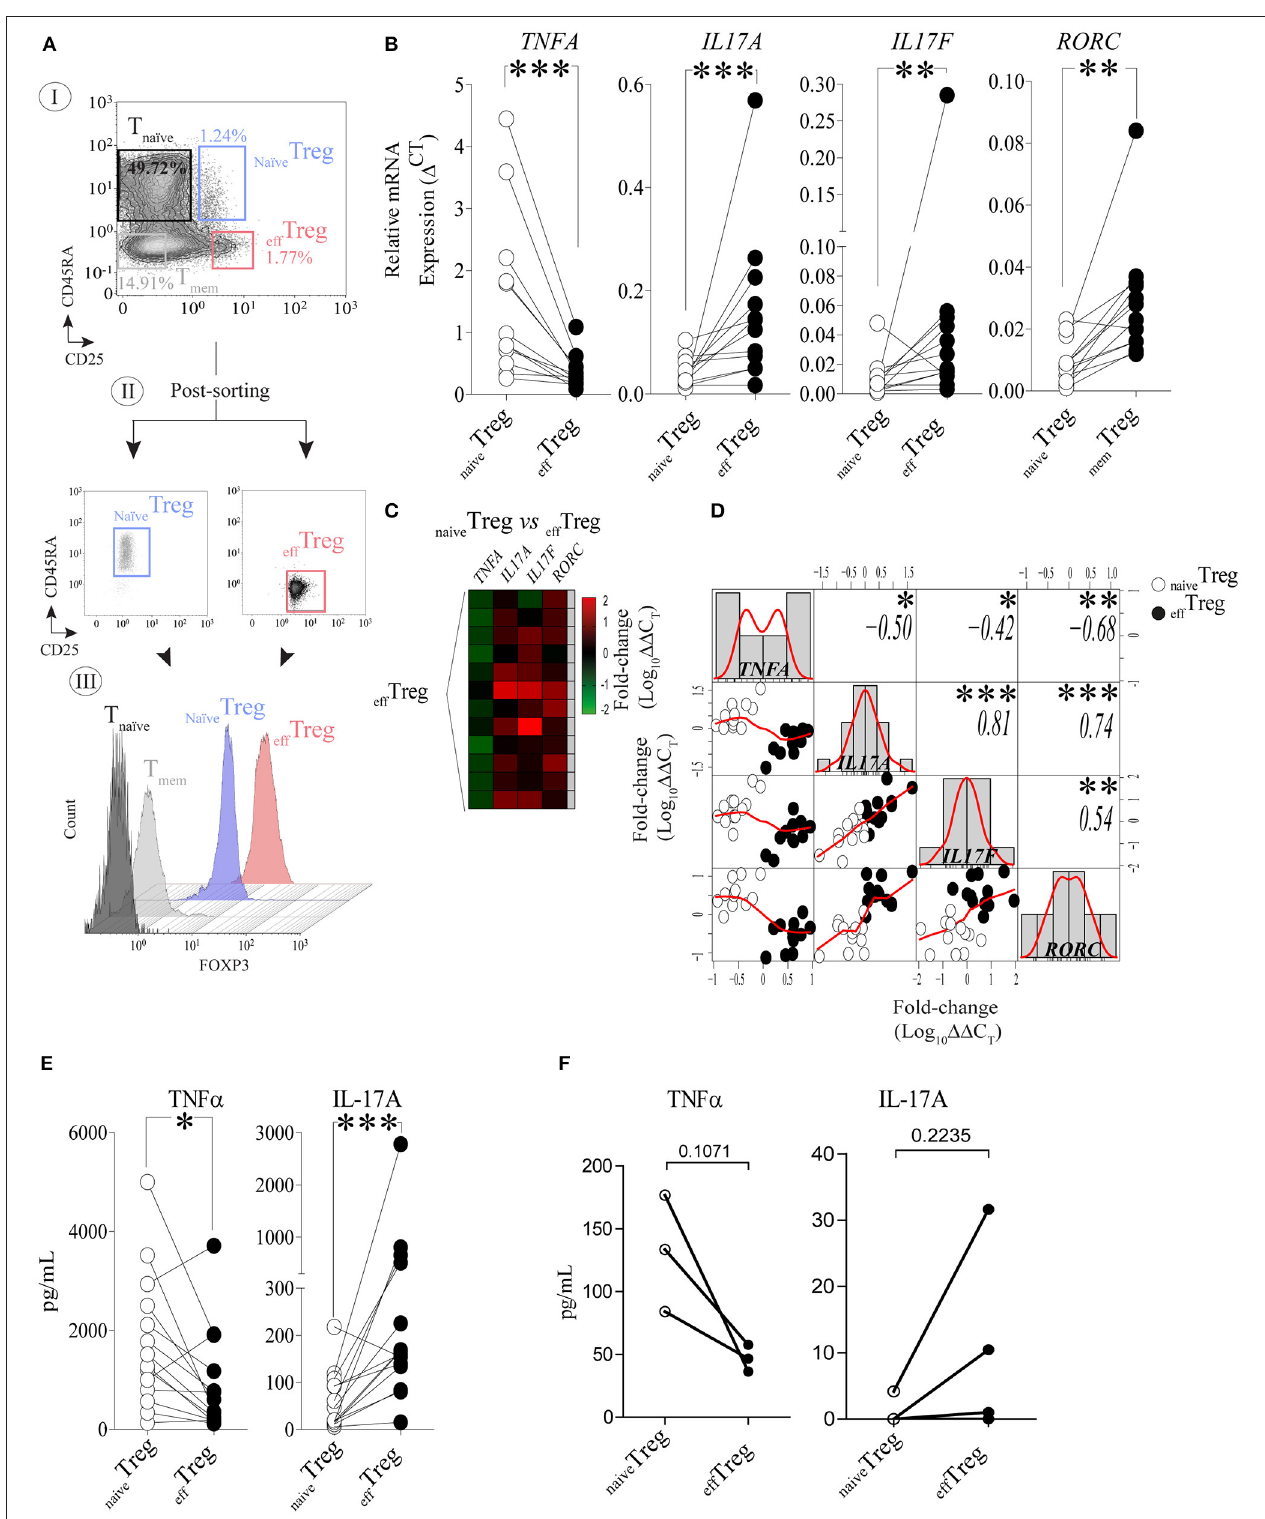
FIGURE 1 | Reciprocal TNF α and IL-17A expression in human naïve Treg and eff Treg cells. (A) An example of the FACS sorting strategy of naïve Treg and eff Treg based on CD4, CD45RA, and CD25 expression (I. dotplots), post-sorting analysis (II. dotplots) and confirmation of FOXP3 expression in the sorted cell population